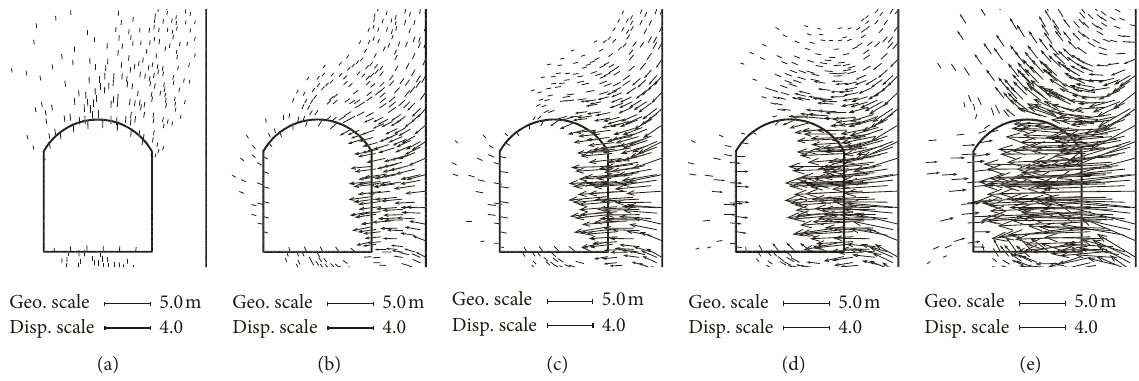
Figure 11: Displacement field of the mining tunnel on five lateral pressure coefficients with right sidewall fault: (a) k (c) k 0 � 1.5; (d) k 0 � 2.0; (e) k 0 �